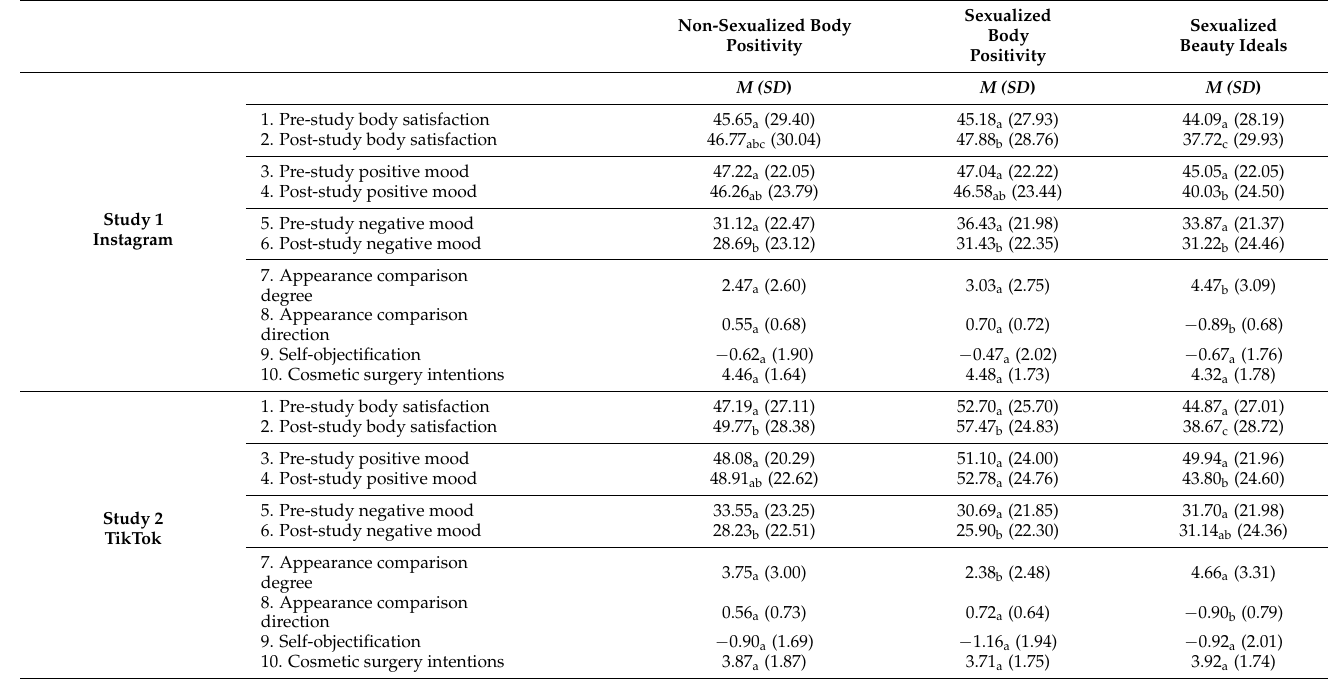
Table 2. Means and Standard Deviations of all the Dependent Variables across Conditions and Separated by